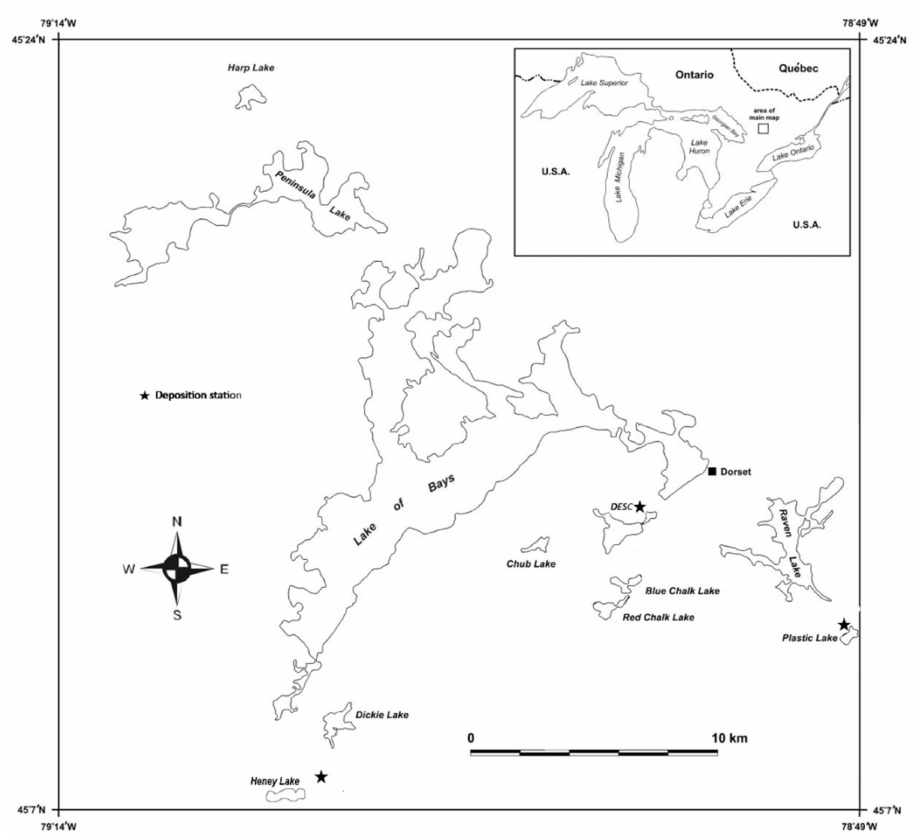
Figure 1. Location of the seven study lakes in south–central Ontario. Stars indicate the location of the three bulk deposition monitoring